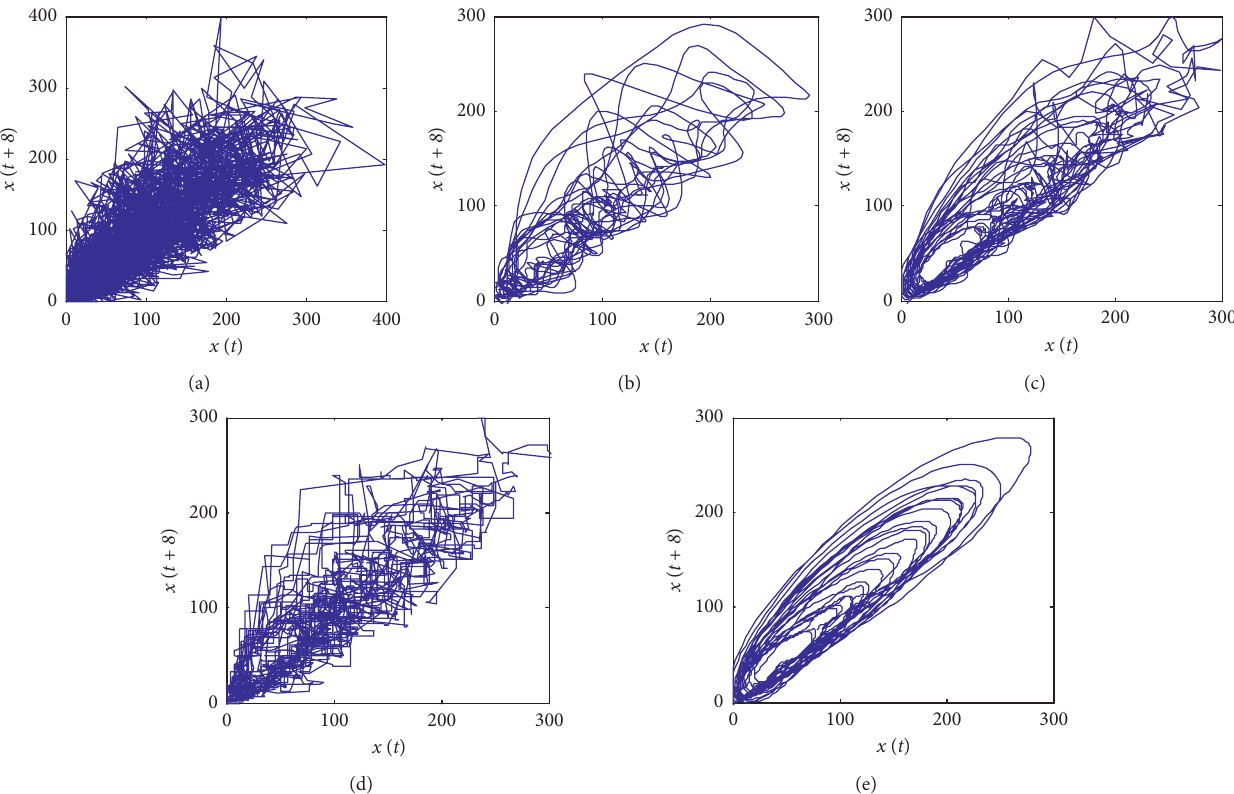
Figure 11: Phase diagrams for the sunspot signal: (a) observation data; (b) the noise reduction result by EMD thresholding; (c) the noise reduction result by wavelet thresholding; (d) the noise reduction result by AMMF; (e) the noise reduction result by ASMMF.